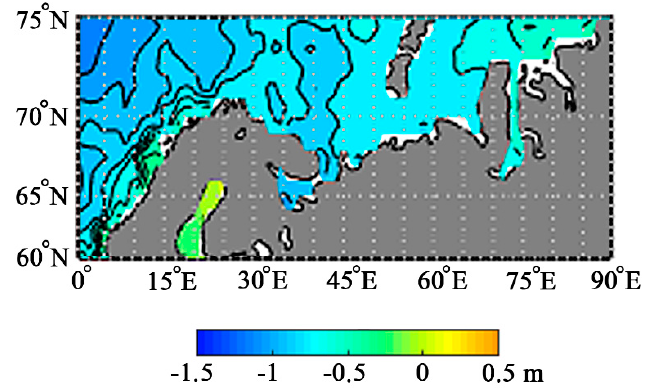
Figure 3. Sea surface height field on 15 July 2013, plotted according to the observation data taken from the Archiving, Validating and Interpolation Satellite Observation (AVISO) archive.